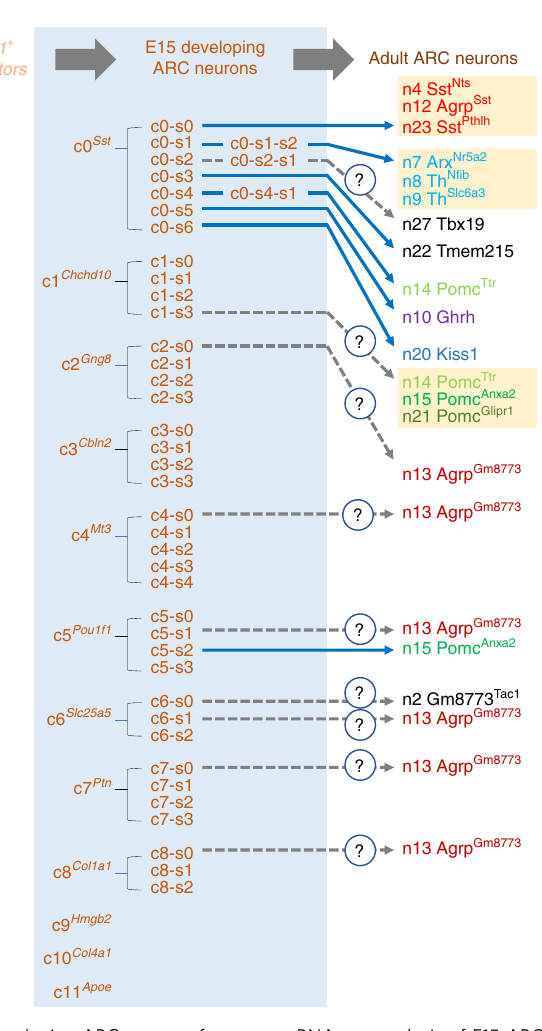
Fig. 3 Developing ARC neurons from our scRNA-seq analysis of E15 ARC. Progenitors labeled by the transcription factor gene Nkx2-1 eventually give rise to different neuronal types in the adult ARC. Relative to the 24 ARC neuronal types de fi ned by a recent RNA-seq analysis of adult ARC 15 , our scRNA-seq analysis of E15 ARC reveals several developing ARC neuronal types. Interestingly, cells in the subclusters c0-s0, c0-s1-s2, and c1-s3 appear to serve as common progenitors to multiple neuronal types in the adult ARC. Cells in the subcluster c0-s0 may represent developing neurons that later segregate to n4 Sst Nts -neurons, n12 Agrp Sst -neurons, and n23 Sst Pthlh -neurons. Cells in the subcluster c0-s1-s2 may become n7 Arx Nr5a2 - neurons, n8 Th N fi b -neurons, and n9 Th Slc6a3 -neurons, while cells in the subcluster c1-s3 may segregate to n14 Pomc Ttr -neurons, n15 Pomc Anxa2 - neurons n21 Pomc Glipr1 -neurons. Cells in the subclusters c0-s3, c0-s4-s1, c0-s5, and c0-s6 may also give rise to n22 Tmem215-neurons, n14 Pomc Ttr -neurons, n10 Ghrh-neurons, and n20 Kisspeptin-neurons,